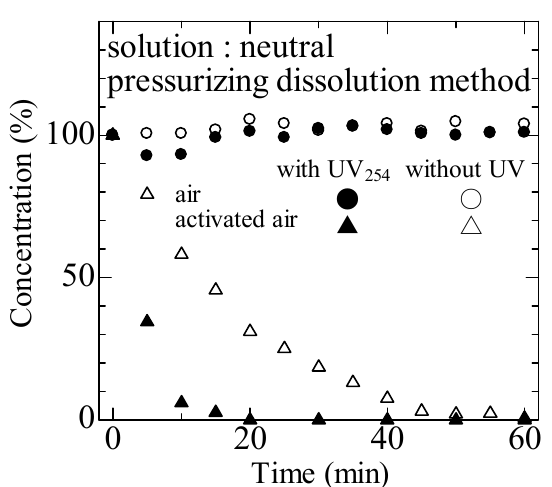
Fig. 9 Time evolution of methylene blue